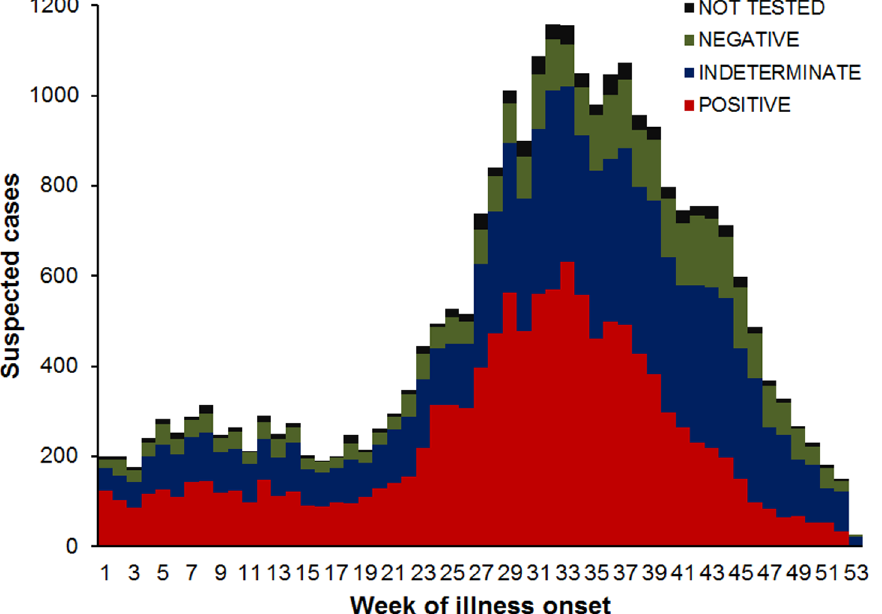
Figure 1. Epidemic curve of suspected dengue cases by week of illness onset, Puerto Rico, 2010. Surveillance data from cases reported via the Passive Dengue Surveillance System, Enhanced Dengue Surveillance System, Notifiable Diseases Surveillance System, or private laboratory dengue diagnostic test results were compiled and grouped by diagnostic test result as indicated.